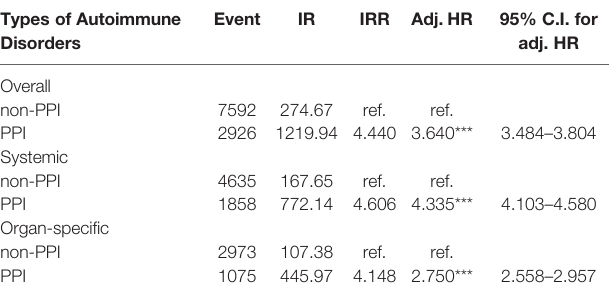
TABLE 2 | Risk of autoimmune disorders between PPI and non-PPI users. Types of Autoimmune